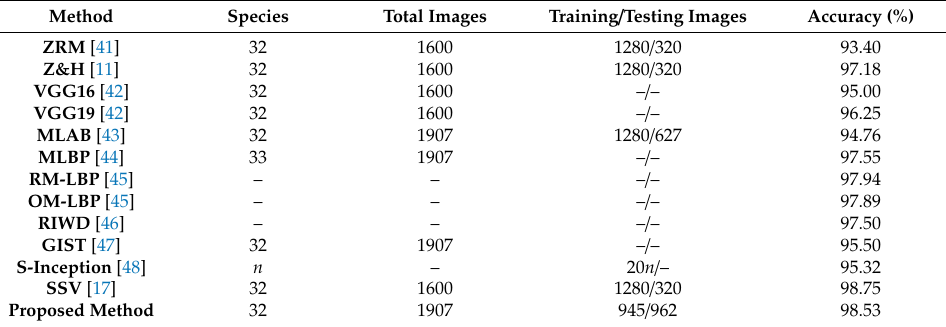
Table 3. Comparison of proposed method with existing methods on Flavia dataset.